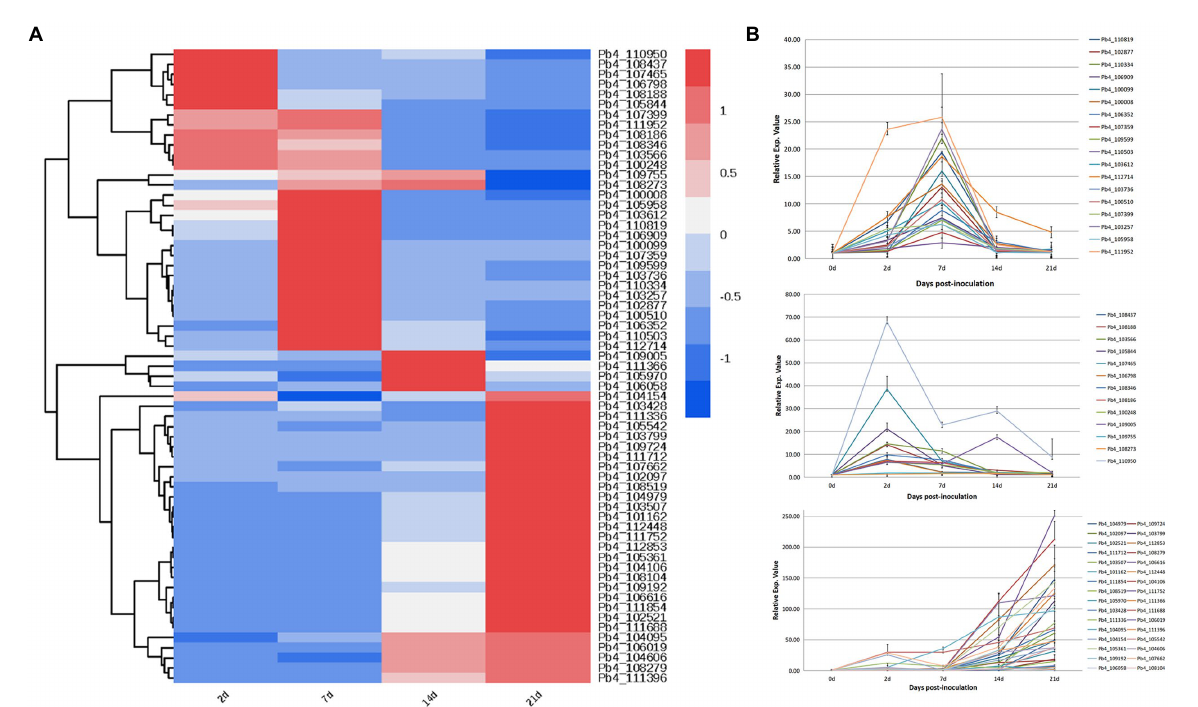
FIGURE 3 Expression profiles of putative effector genes in the root samples of Brassica rapa infected with P. brassicae . (A) Cluster analysis heat map of all P. brassicae effector genes. (B) The expression level of these effector genes in different